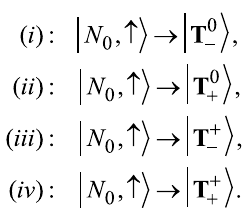
Notice that, in our model, the bias voltage at which a tip-medi- ated transition from the m -th neutral state to the n -th anionic state of the molecule is happening